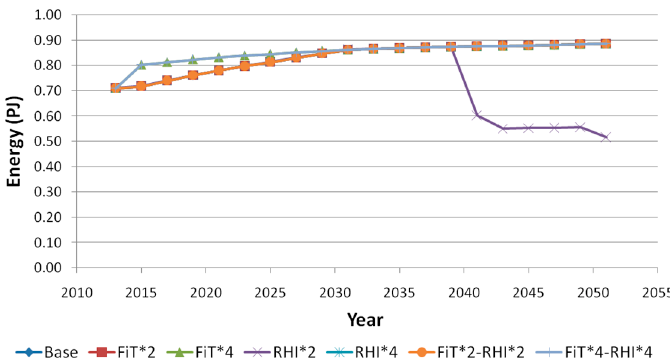
Figure 13. LFA farms—grid electricity consumption.